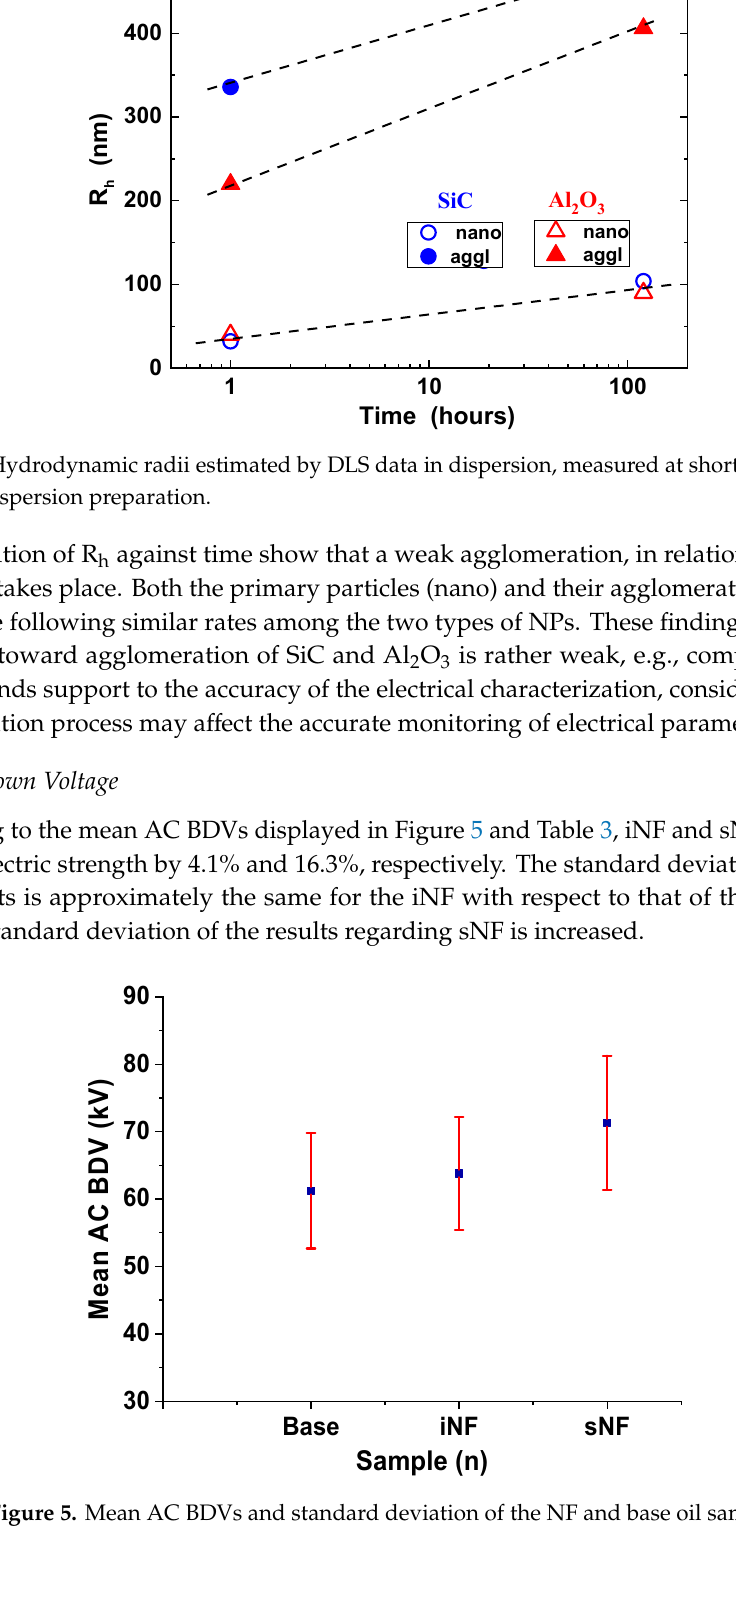
Figure 5. Mean AC BDVs and standard deviation of the NF and base oil samples.